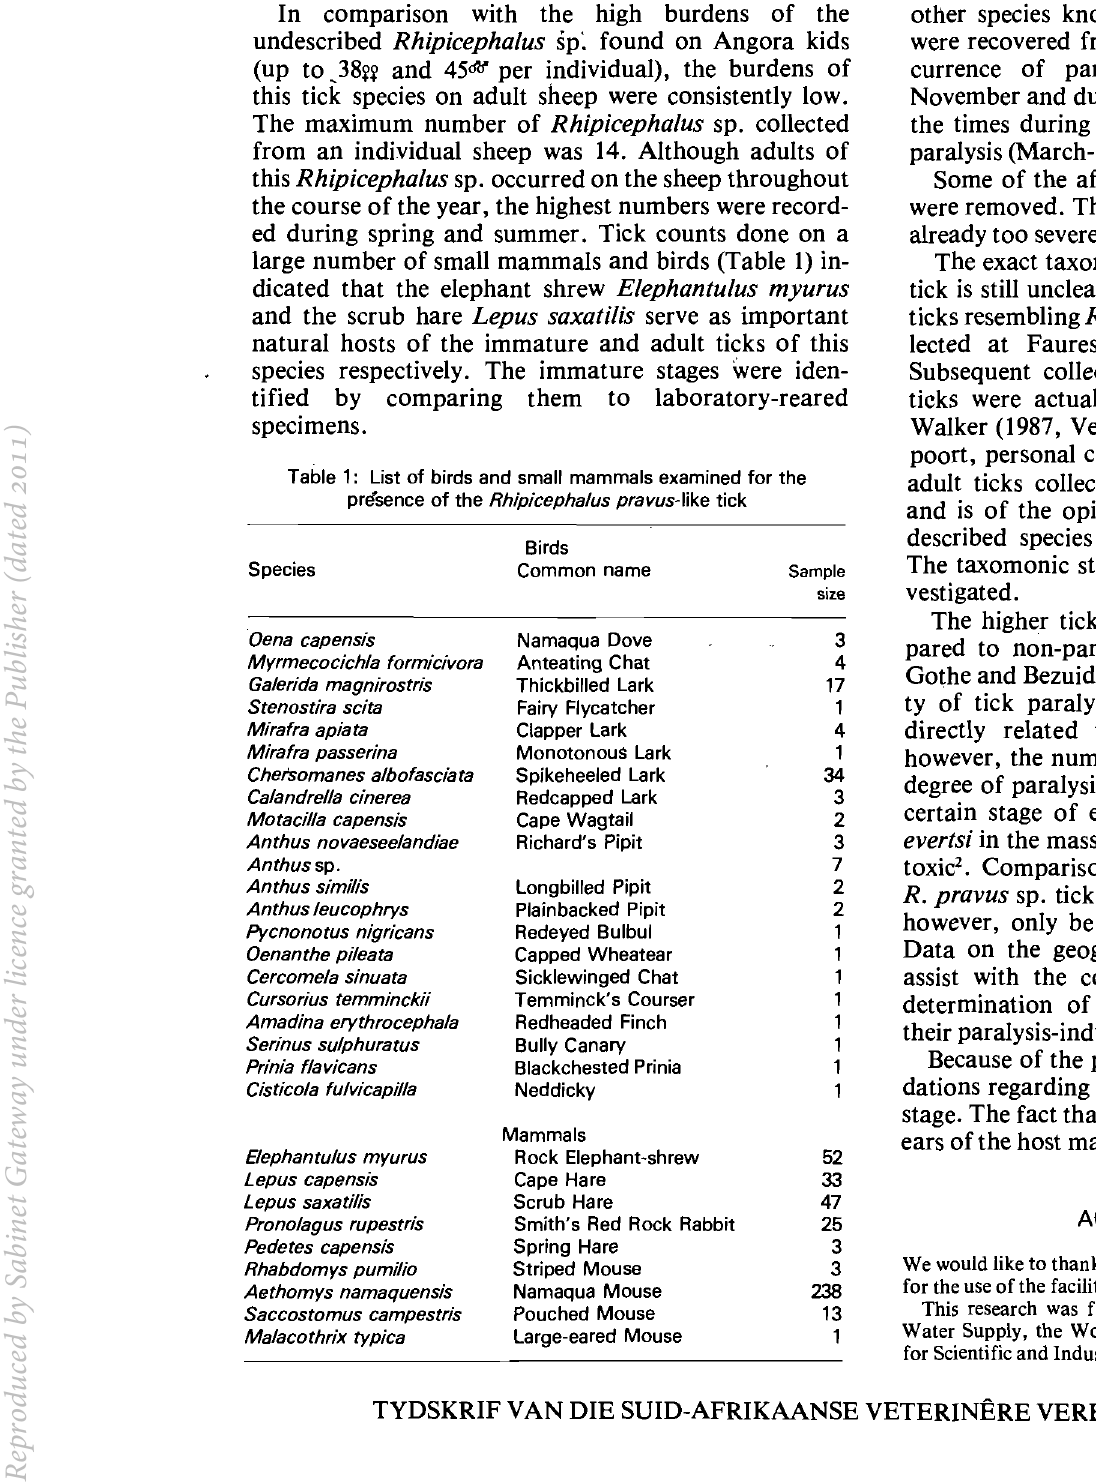
Table 1: List of birds and small mammals examined for the pre'sence of the Rhipicephalus pravus-like